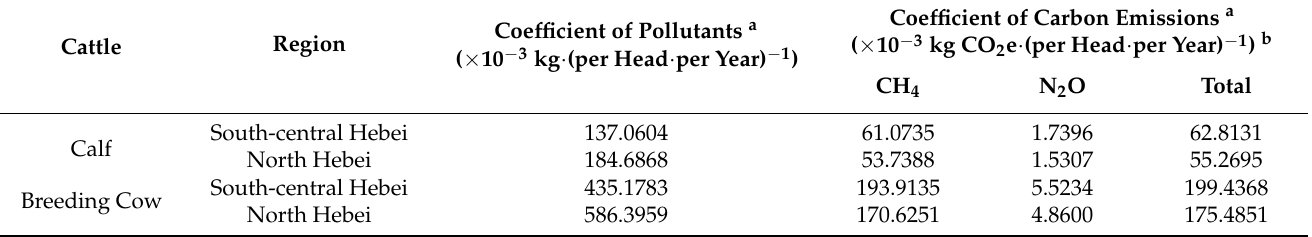
Table 1. Coefficients of Pollutants and Carbon Emissions of Beef Calf Production in Different Survey